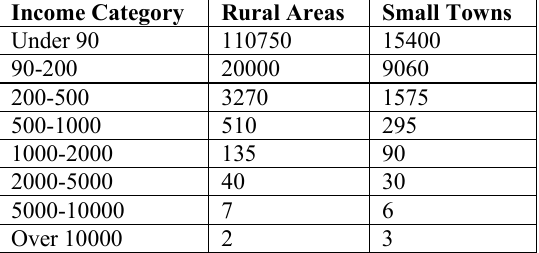
Table 1: The Number of Rich will continue to Explode Income